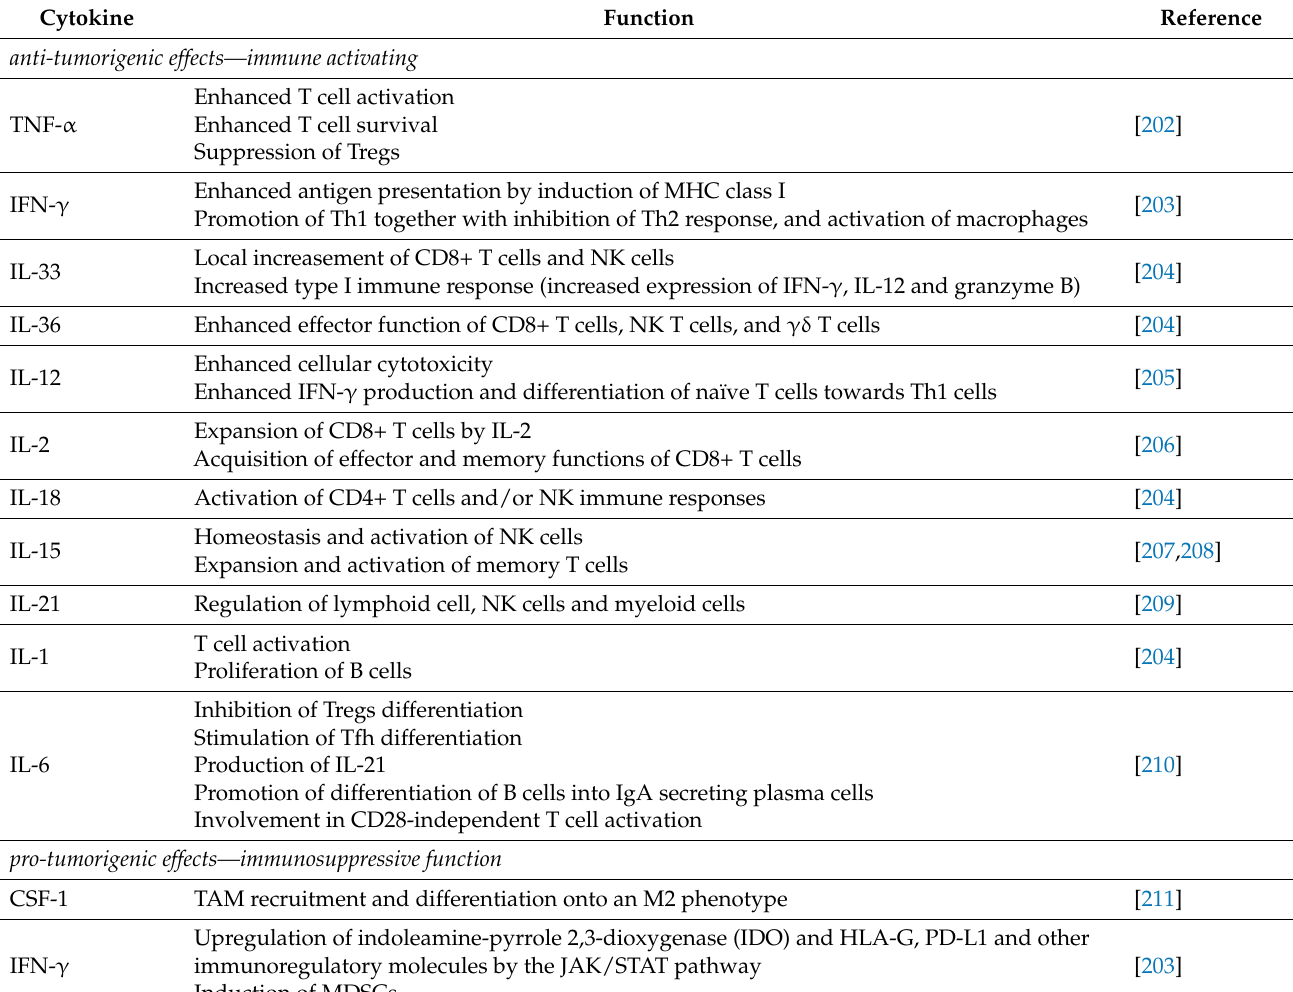
Table 4. Cytokines with immune activating or immunosuppressive function. Cytokine Function